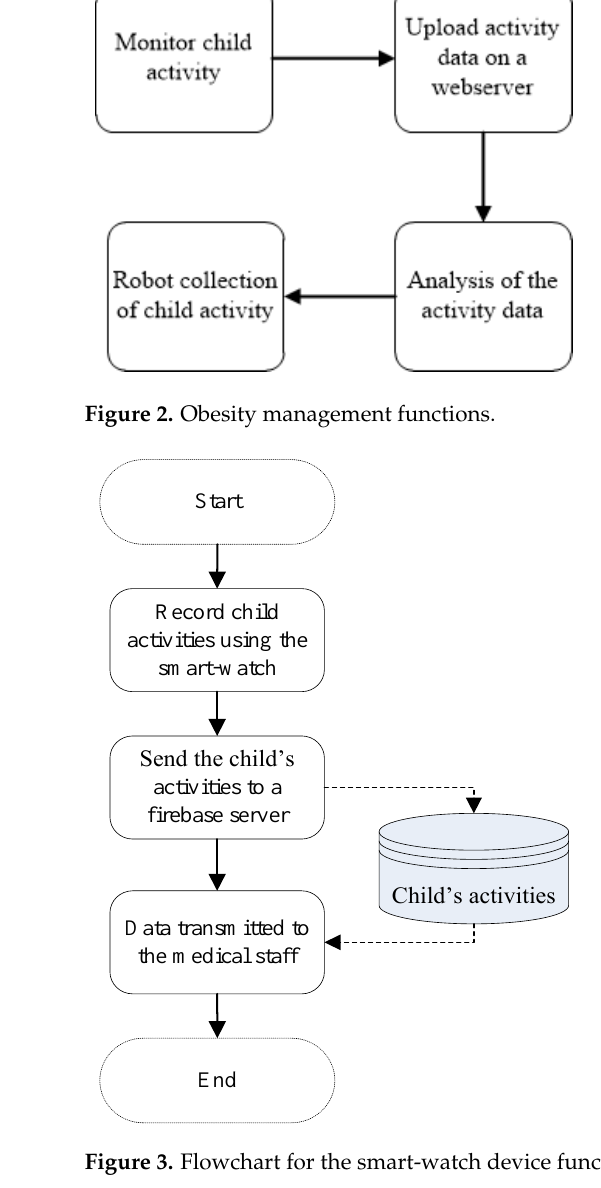
Figure 3. Flowchart for the smart-watch device function.